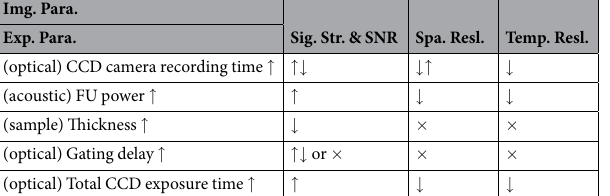
Table 3. Exp. Para.: experimental parameters; Imag. Para.: image parameters; Sig. Str.: signal strength; Spa. Resl.: spatial resolution; Temp.Resl.: temporal resolution. ↑ : increase; ↓ : decrease; ↑↓ : increase and then decrease; ↓↑ : decrease and then increase; × : not